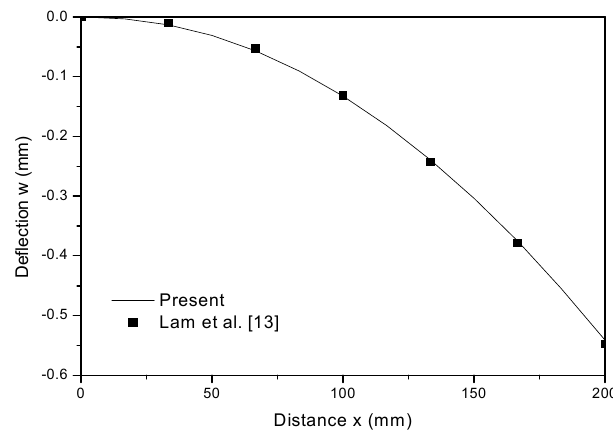
Figure 4. Deflection plot of the model with piezoelectric loads.